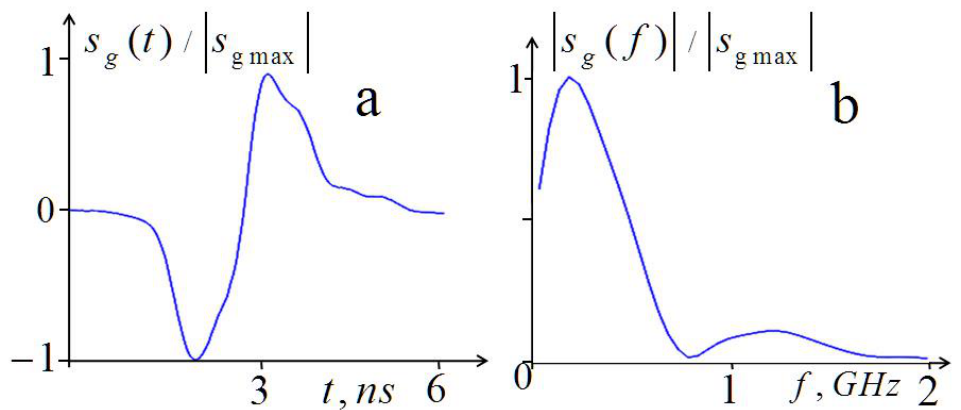
Figure 1. Shape of the generator pulse ( a ) and its frequency spectrum ( b ).